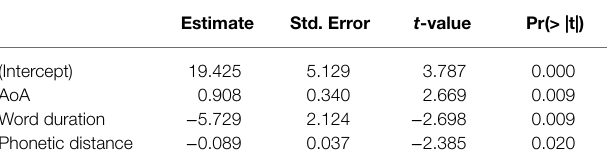
TABLE 2 | Results of a linear regression model of the relation between F-letter scores and the average values of the selected language measures. Estimate Std. Error t -value Pr(>